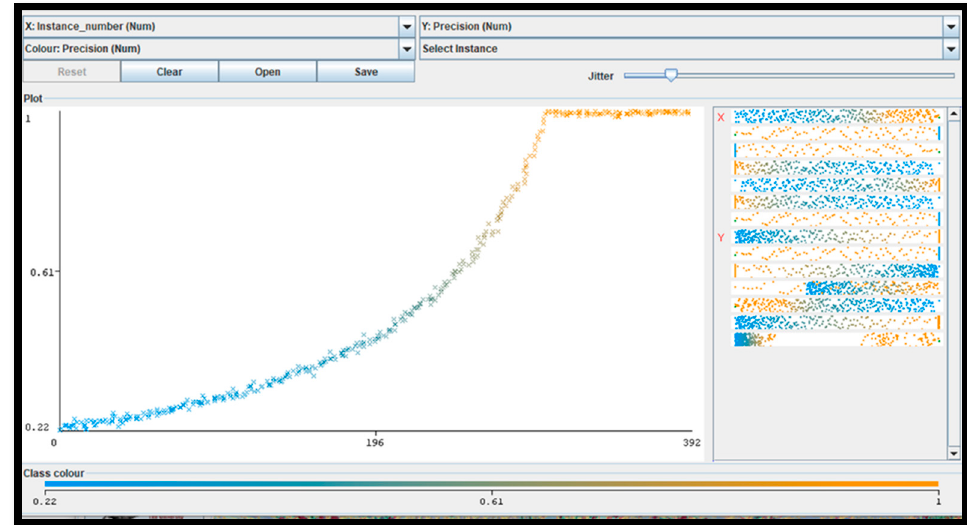
Figure 2. This figure illustrates the error metric (precision parameter [5]) of the adopted FRF algorithm versus iteration number (instance number) by proving that the final results are characterized by the maximum precision.